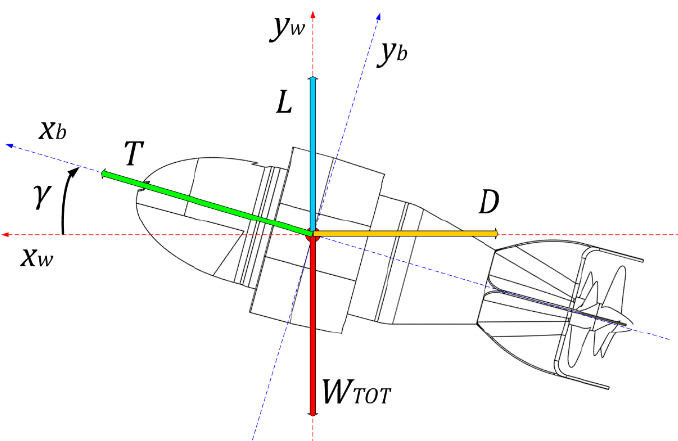
Figure 7. AUV Albacore: force balance on the XY plane.